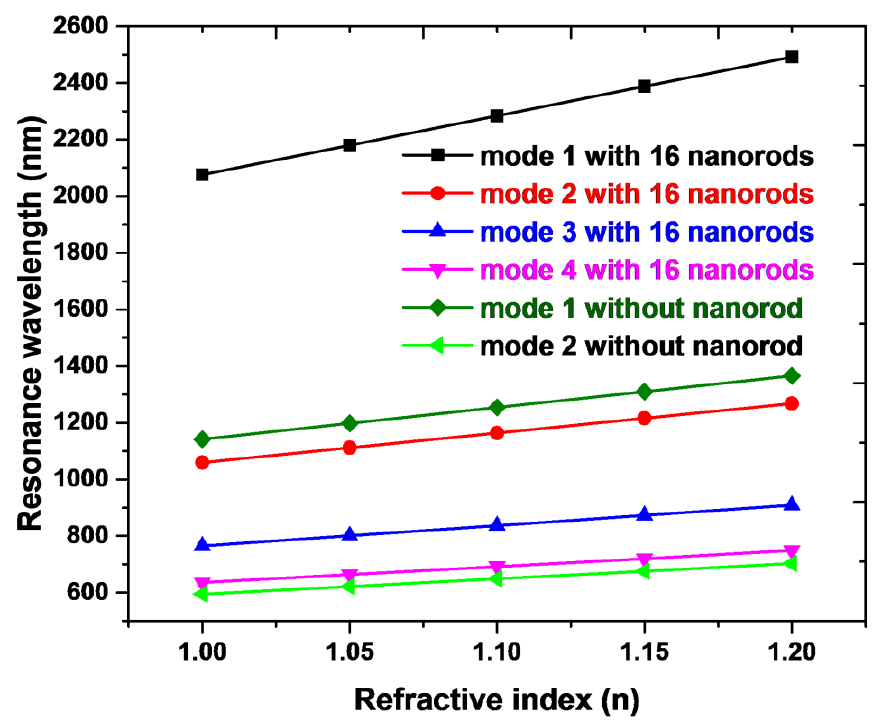
Figure 5. Calculated resonance wavelength (λ res ) of mode 1–2 for the cases without silver nanorods and mode 1–4 for the cases with 16 silver nanorods versus the refractive index. The other geometric parameters, w , h , R , and r , are set to be 50, 10, 100, and 20 nm, respectively.